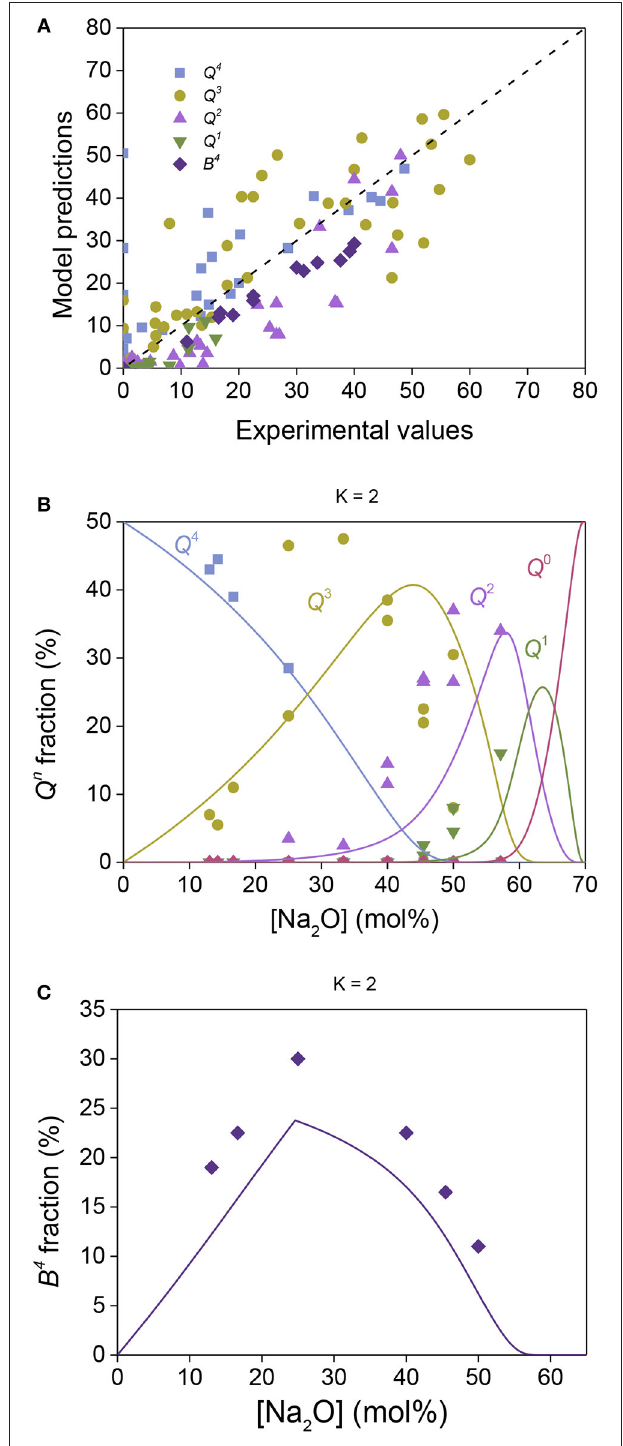
FIGURE 4 | Sodium borosilicate structural data obtained by 29 Si and 11 B MAS NMR (Bhasin et al., 1998; Nanba et al., 2004) compared to model predictions. (A) All experimental data plotted against the model predictions, with the dashed line showing a one-to-one correlation. (B) Composition dependence of Q n fractions in sodium borosilicate glasses with K = 2, where the symbol represents experimental data by 29 Si MAS NMR and the lines